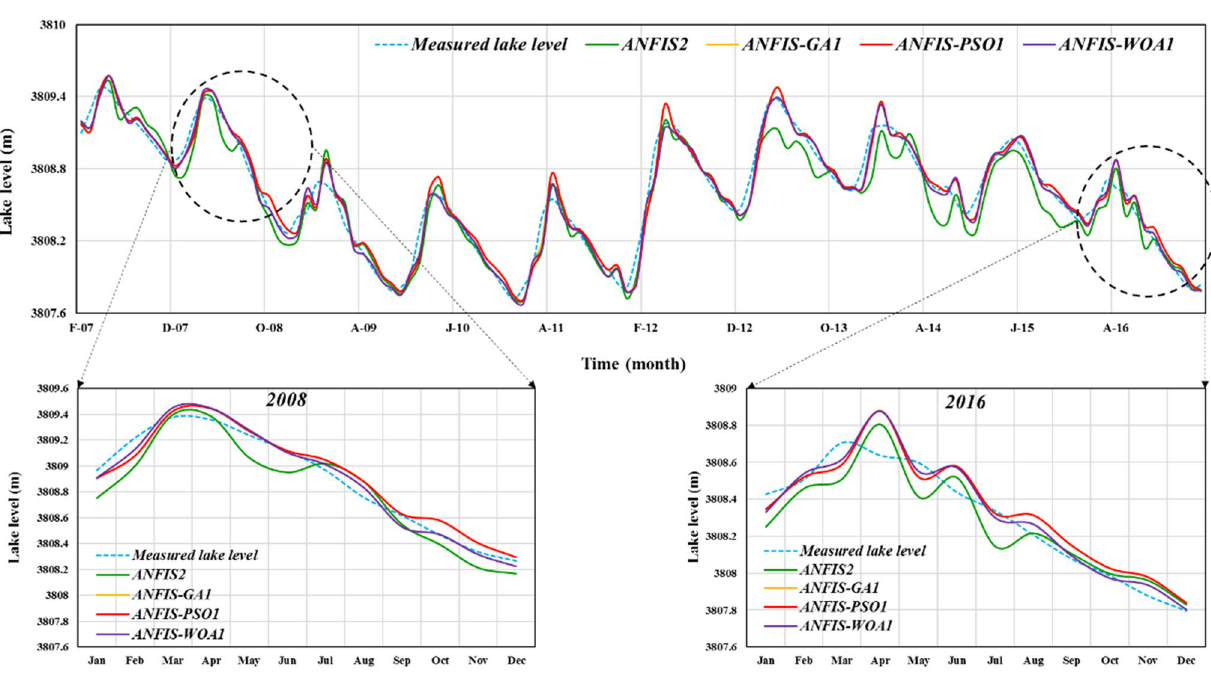
Fig. 8 Time series plot of measured-predicted Titicaca water level for best models in the nominated